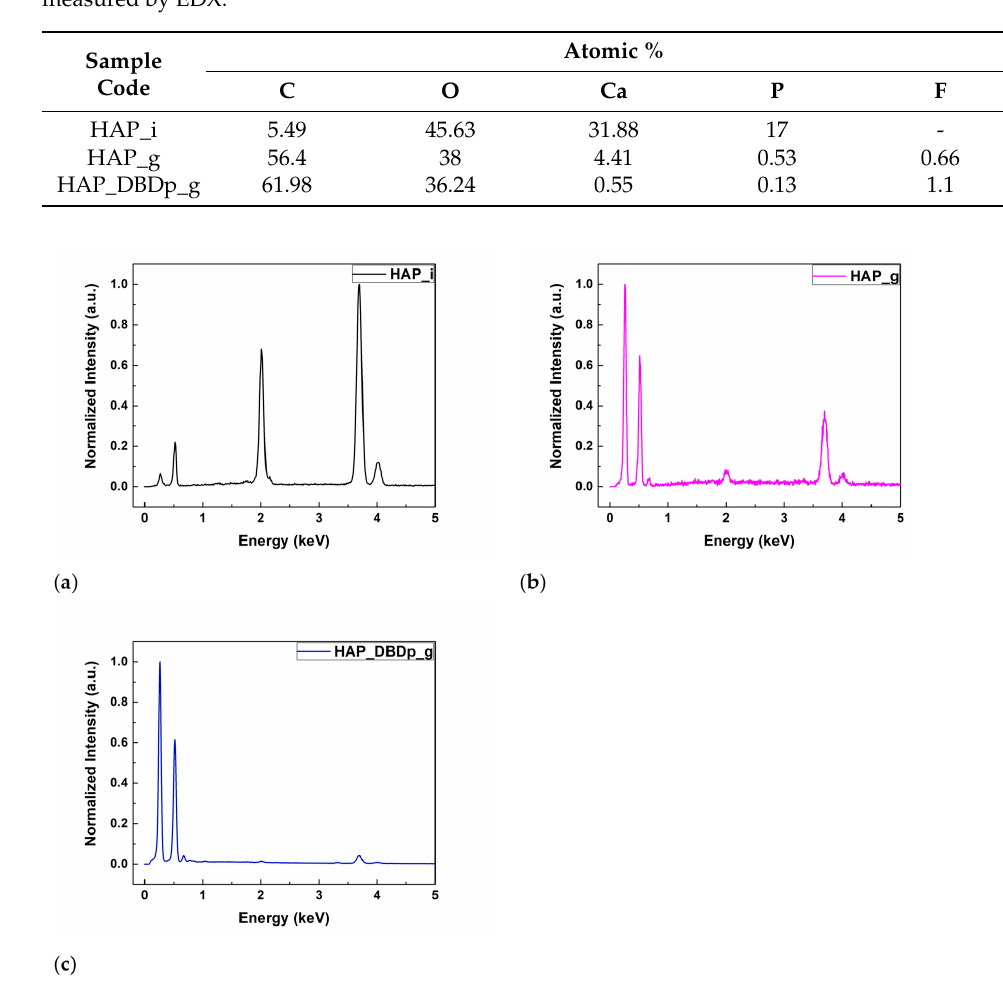
Figure 1. EDX spectra of ( a ) HAP_i; ( b ) HAP_g; ( c ) HAP_DBDp_g. It can be observed that a higher percentage of C is obtained for the gel-treated sam- ples. The atomic percentage of O is higher for HAP_i and similar for the plasma-treated